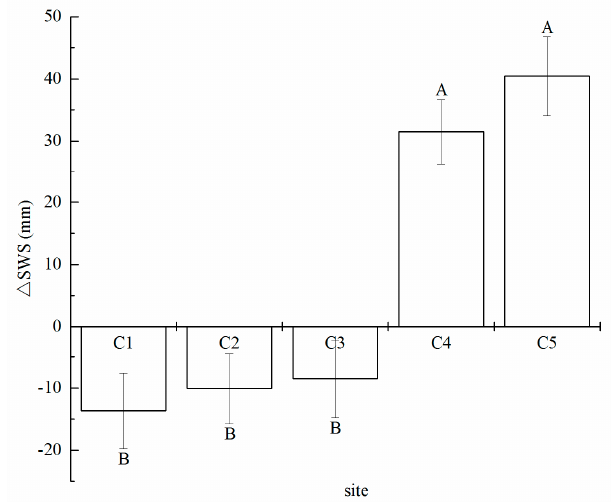
Figure 7. The variation in soil water storage (0–200 cm) at each monitoring site in the cropland. Different letters indicate significant differences ( p <0.05).